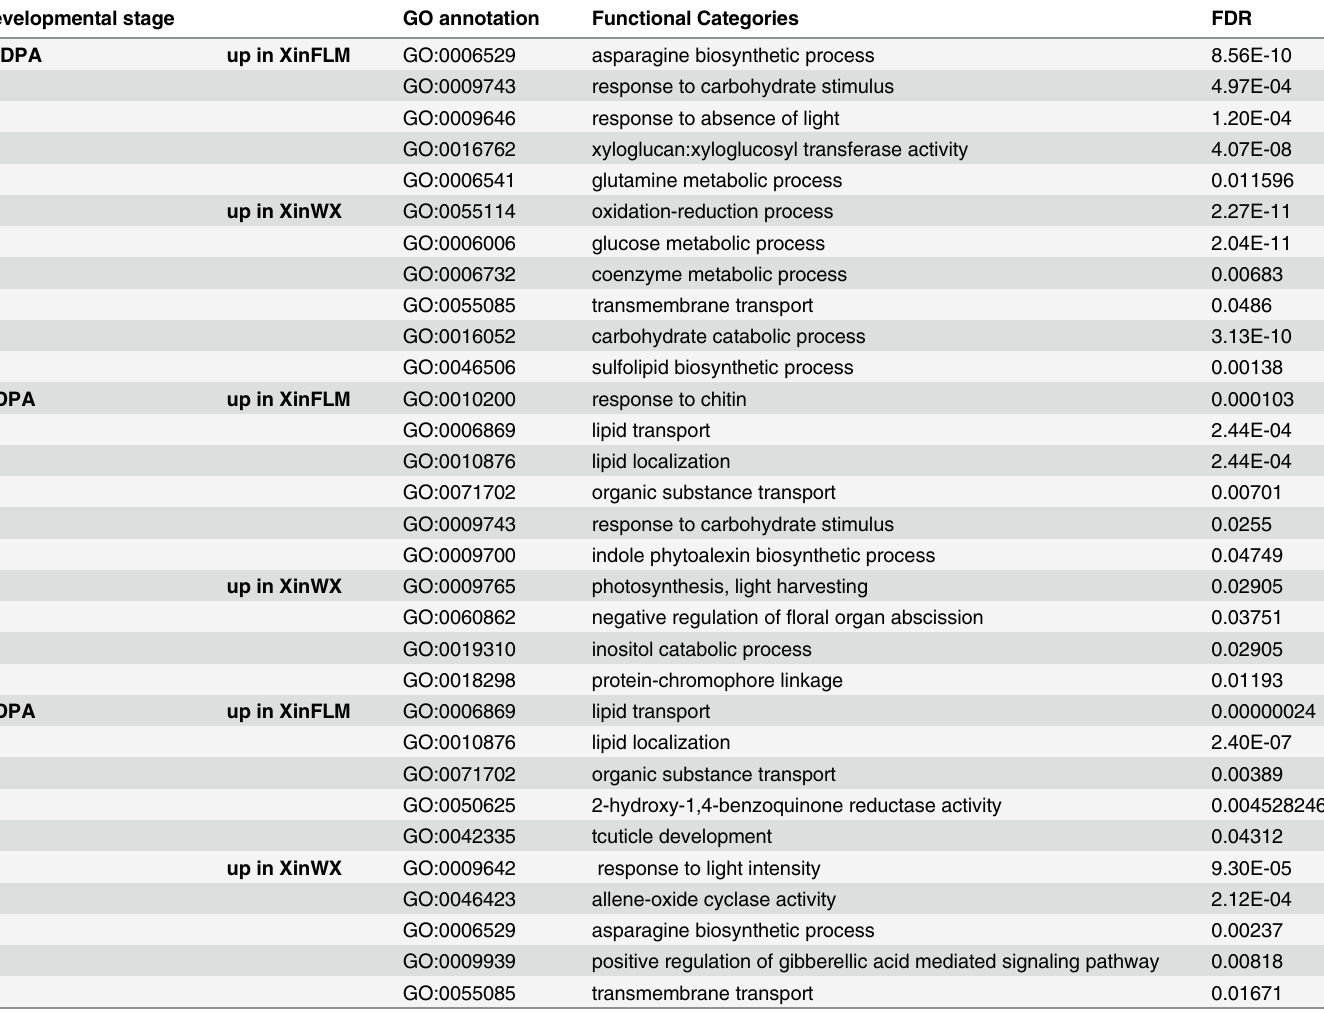
Table 2. Specific GO terms enriched between XinFLM and XinWX at three time points. Developmental